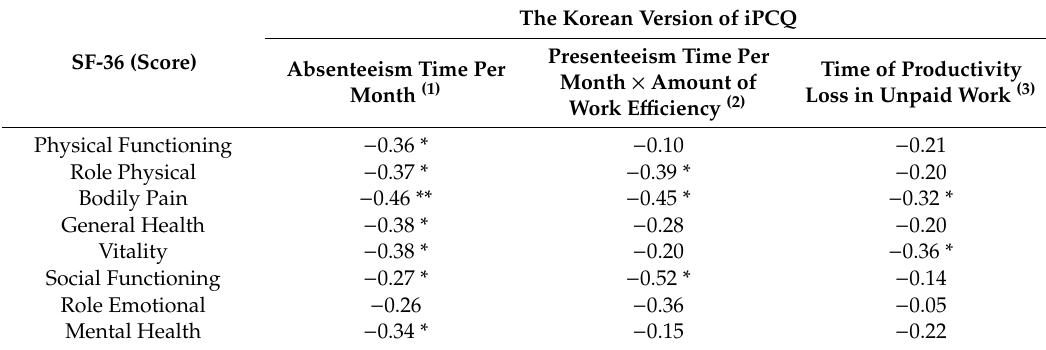
Table 5. Construct validity results using Spearman’s rank